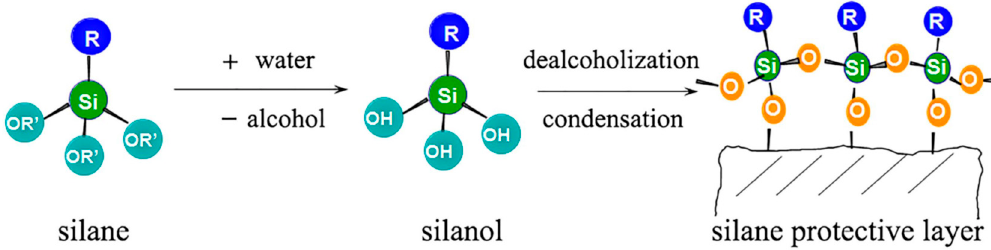
Figure 6. Reaction diagrammatic sketch of silane protective layer [107].